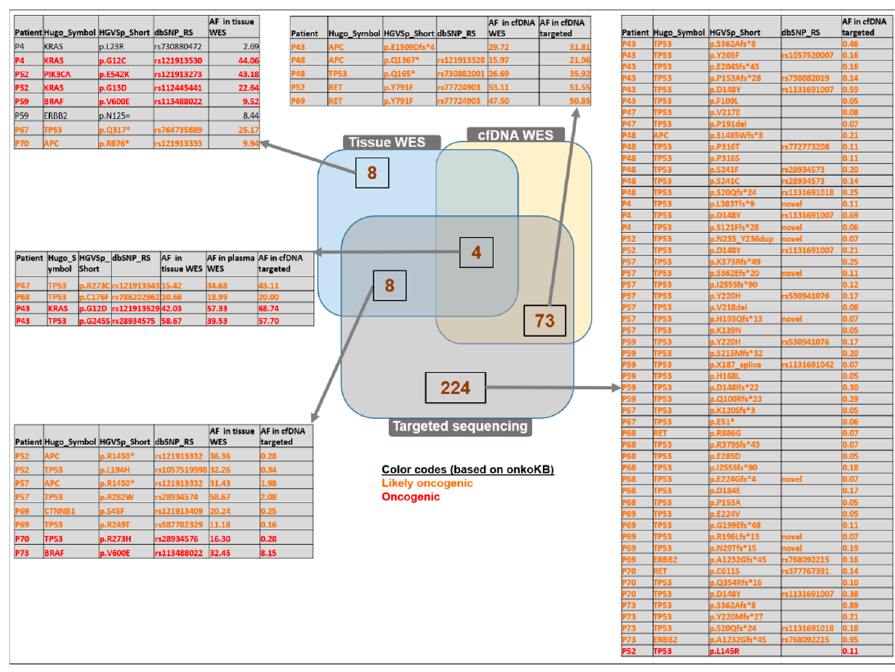
Figure 7. Comparison of the identified variants analyzed with WES of tissue, WES of matched plasma, and targeted sequencing methods. Venn diagram representation defines the number of variants identified commonly or exclusively found with the above-mentioned applied methods. Only the “likely oncogenic” or “oncogenic” variants are listed among the targeted-panel-specific variants and among those detected by both cfDNA WES and targeted panel sequencing. The complete lists can be found in Table S3.